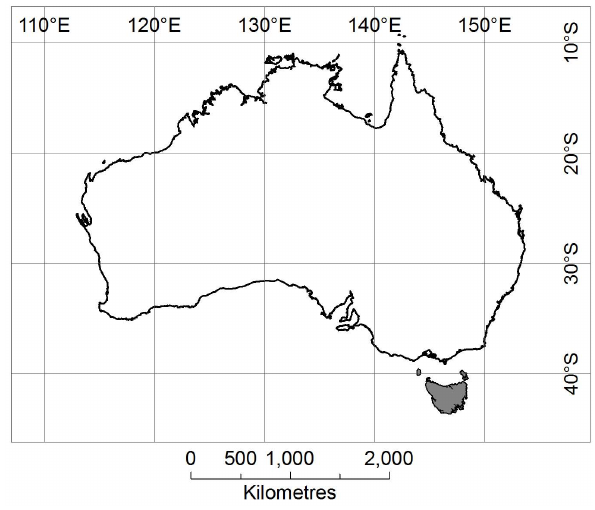
Fig. 1. Tasmania’s location (shaded) in relation to the Australian